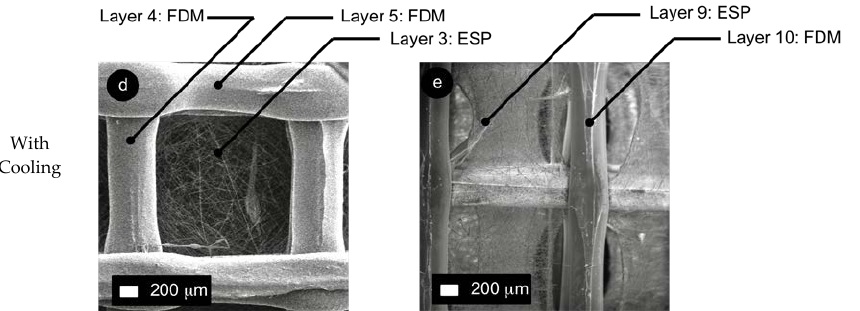
Figure 5. Influence of cooling system on scaffold morphology with 11 layers for scaffold Type A with polylactic acid (PLA) strands electrospun polycaprolactone (PCL) microfibers: ( a ) scaffold design with 11 layers; ( b , c ) electrospun mat morphology without cooling; and ( d , e ) electrospun mat morphology